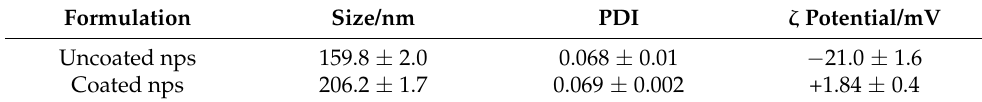
Table 4. Summary of dynamic light scattering measurements of uncoated and coated